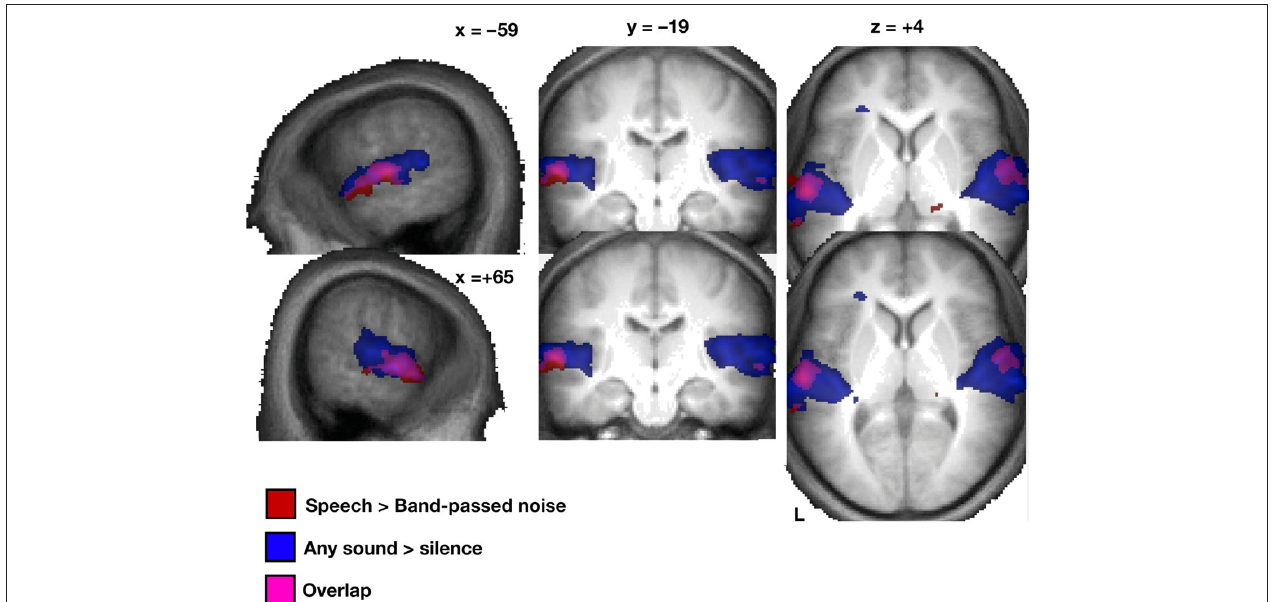
FIguRe 2 | Random effects ( N = 16) of the univariate analysis for speech > band-passed noise (red) and sound > silence (blue; overlay purple) based on smoothed and normalized individual contrast maps, thresholded